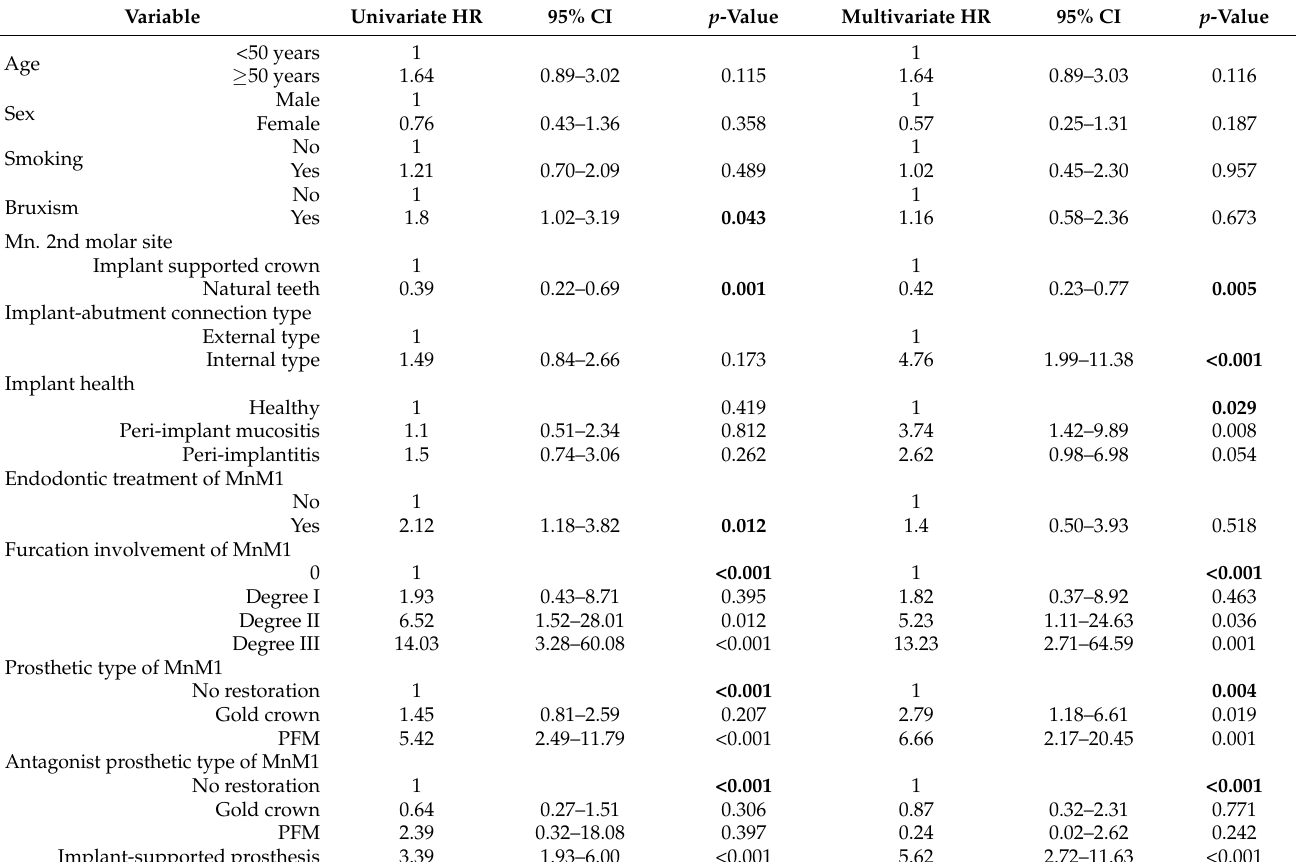
Table 3. Cox proportional hazard ratio for the loss of the mandibular first molar adjacent to an implant placed in the mandibular second molar